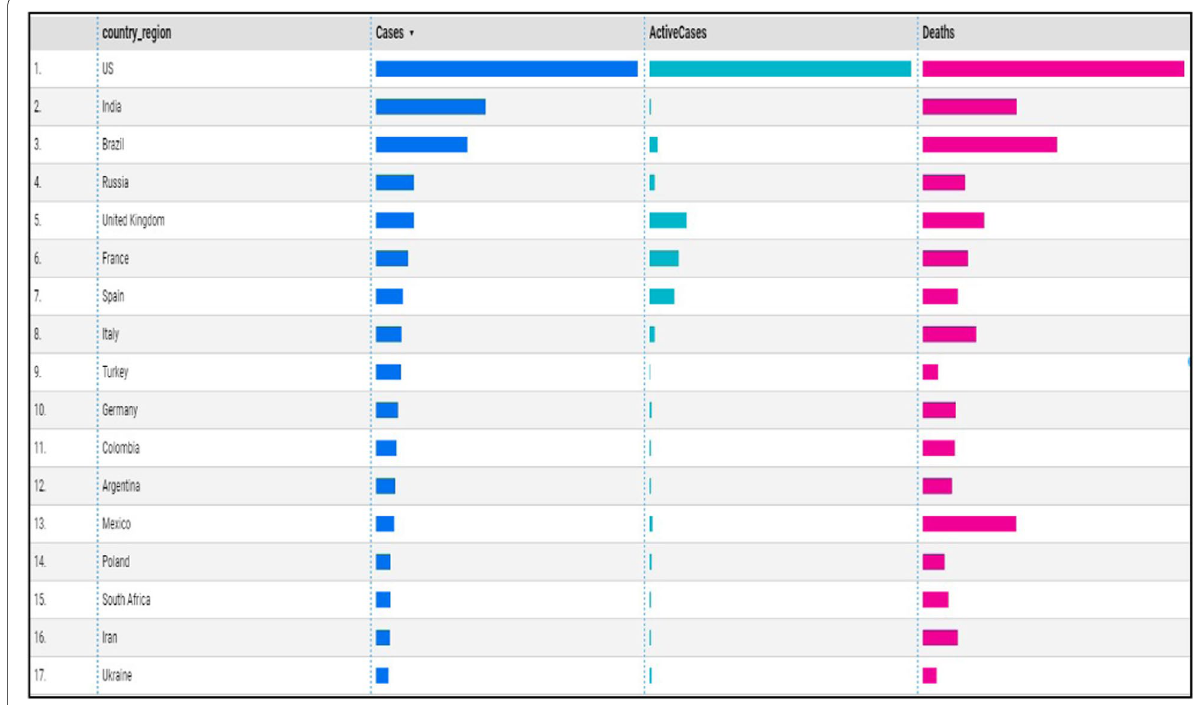
Fig. 11 Using data studio for data